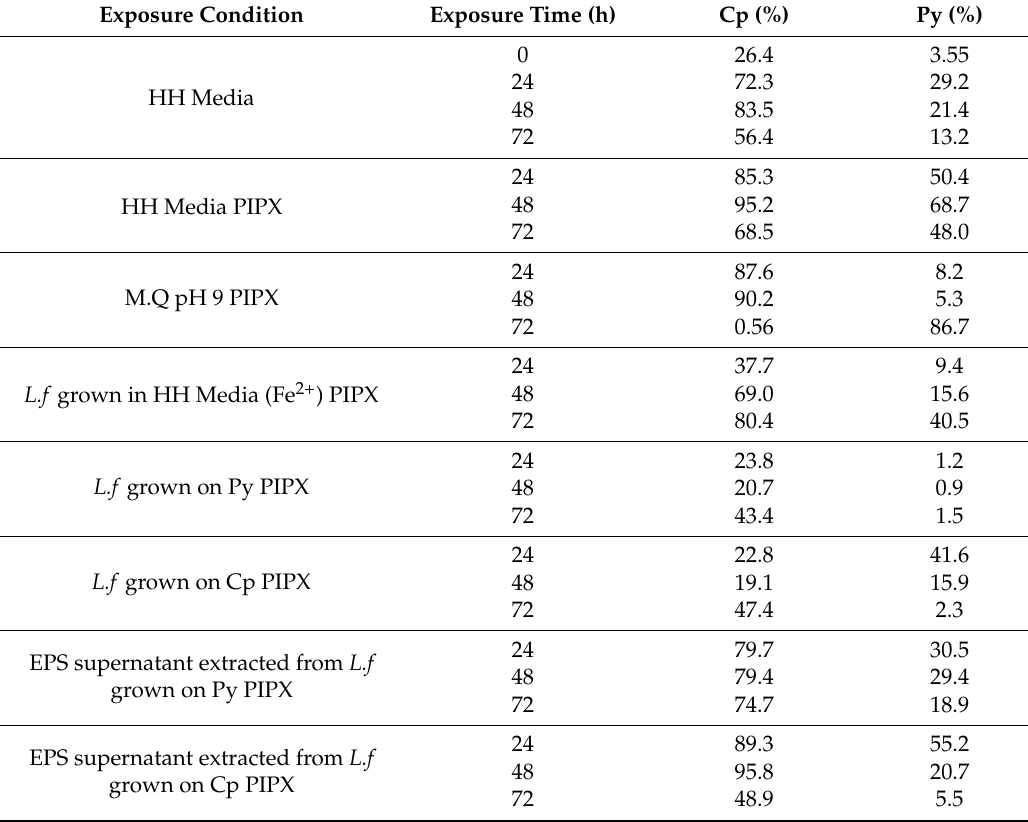
Table 3. Comparison of bio-flotation tests as a function of wt % recovered for growth, EPS, and PIPX. Standard deviation was less than 0.15 for all